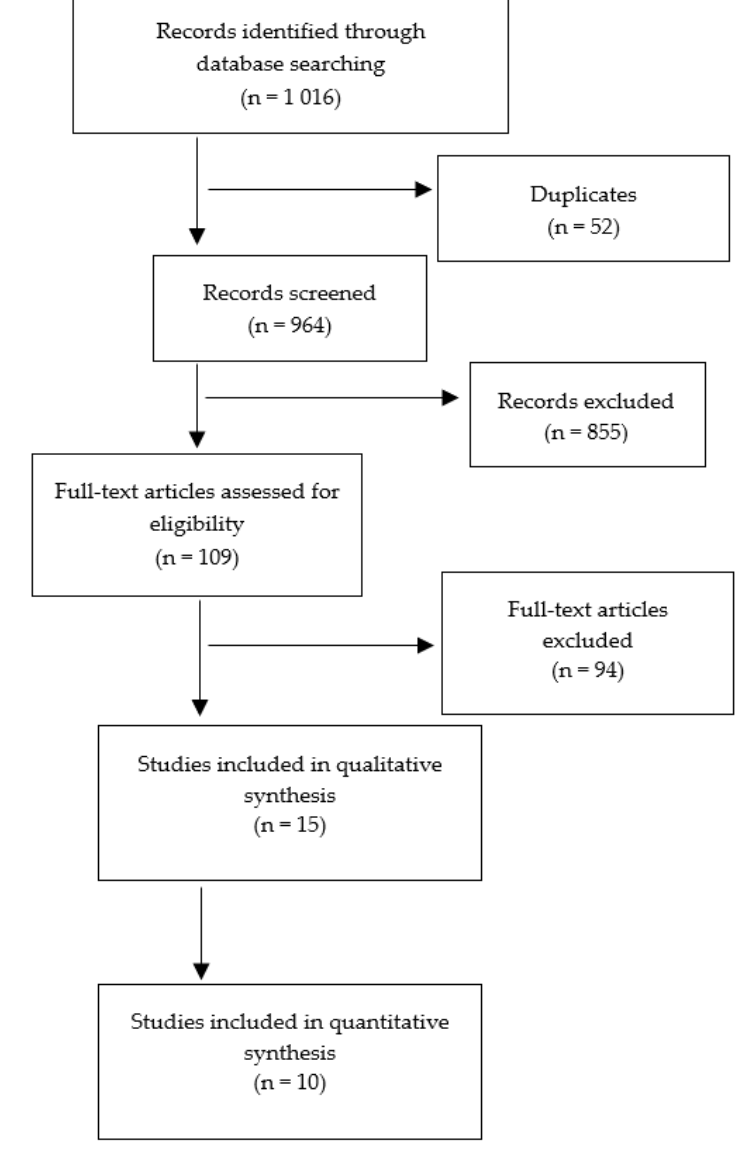
Figure 1. Flow diagram of study selection and inclusion.